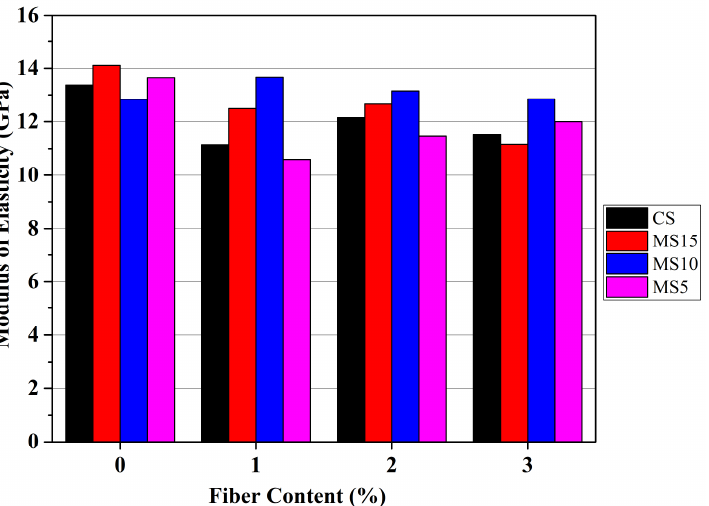
Figure 22. Modulus of elasticity values of the mortar samples with various fiber content .